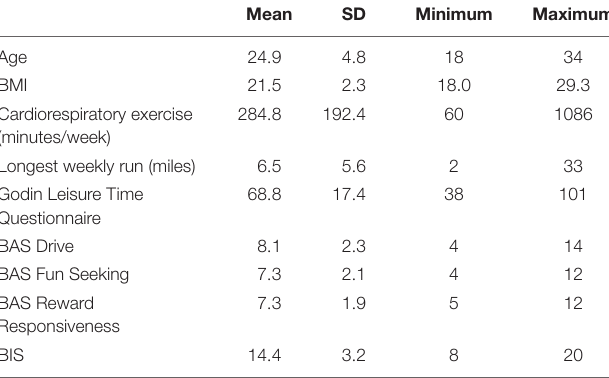
TABLE 3 | Study 2 sample characteristics ( n =